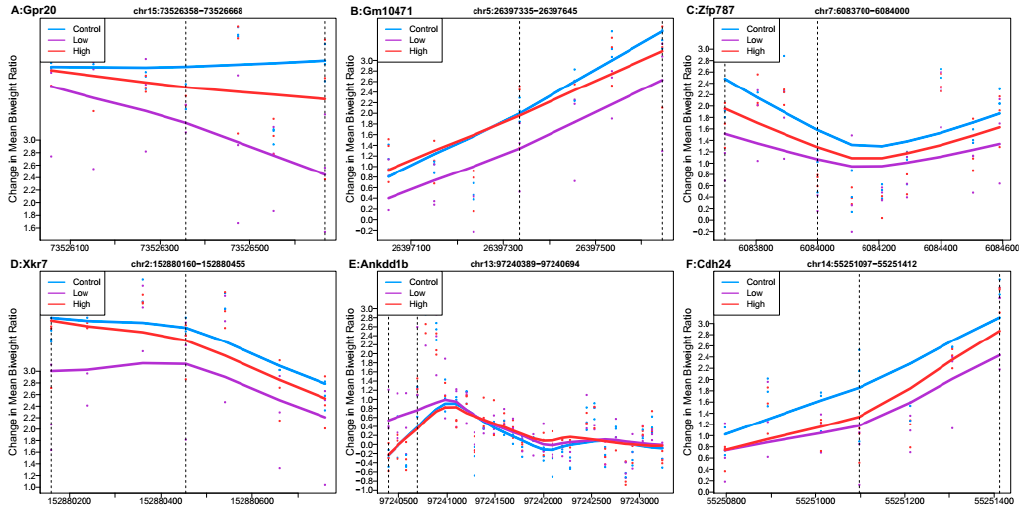
Figure 2. Di ff erentially methylated regions associated with low perinatal Pb exposure (2.1 ppm) relative to controls. Regions within dashed lines indicate the di ff erentially methylated region. Areas outside boundary are plotted to show the trend outside the region. Nearest gene to regions: ( A ) G protein-coupled receptor 20 ( Gpr20 ), chromosome 15:73526358-73526668. ( B ) Predicted gene 10471 ( Gm10471 ), chromosome 5:26397335-26397645. ( C ) Zinc finger protein 787 ( Xfp787 ), chromosome